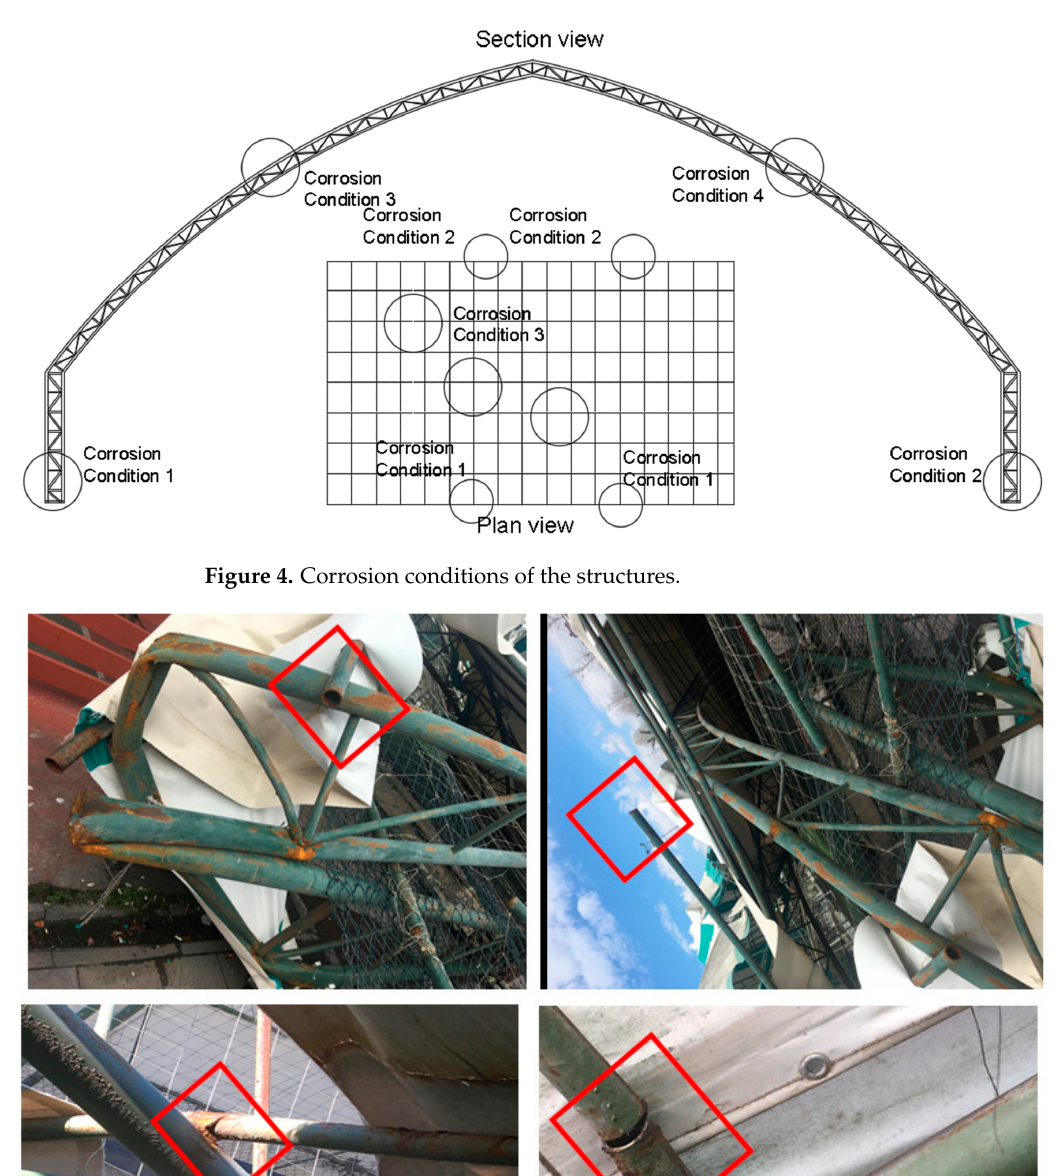
Figure 5. Observed damage on purlin connections.